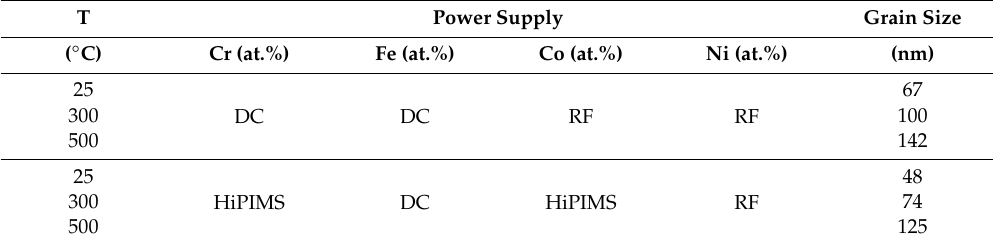
Table 4. Columnar grain widths determined in TEM